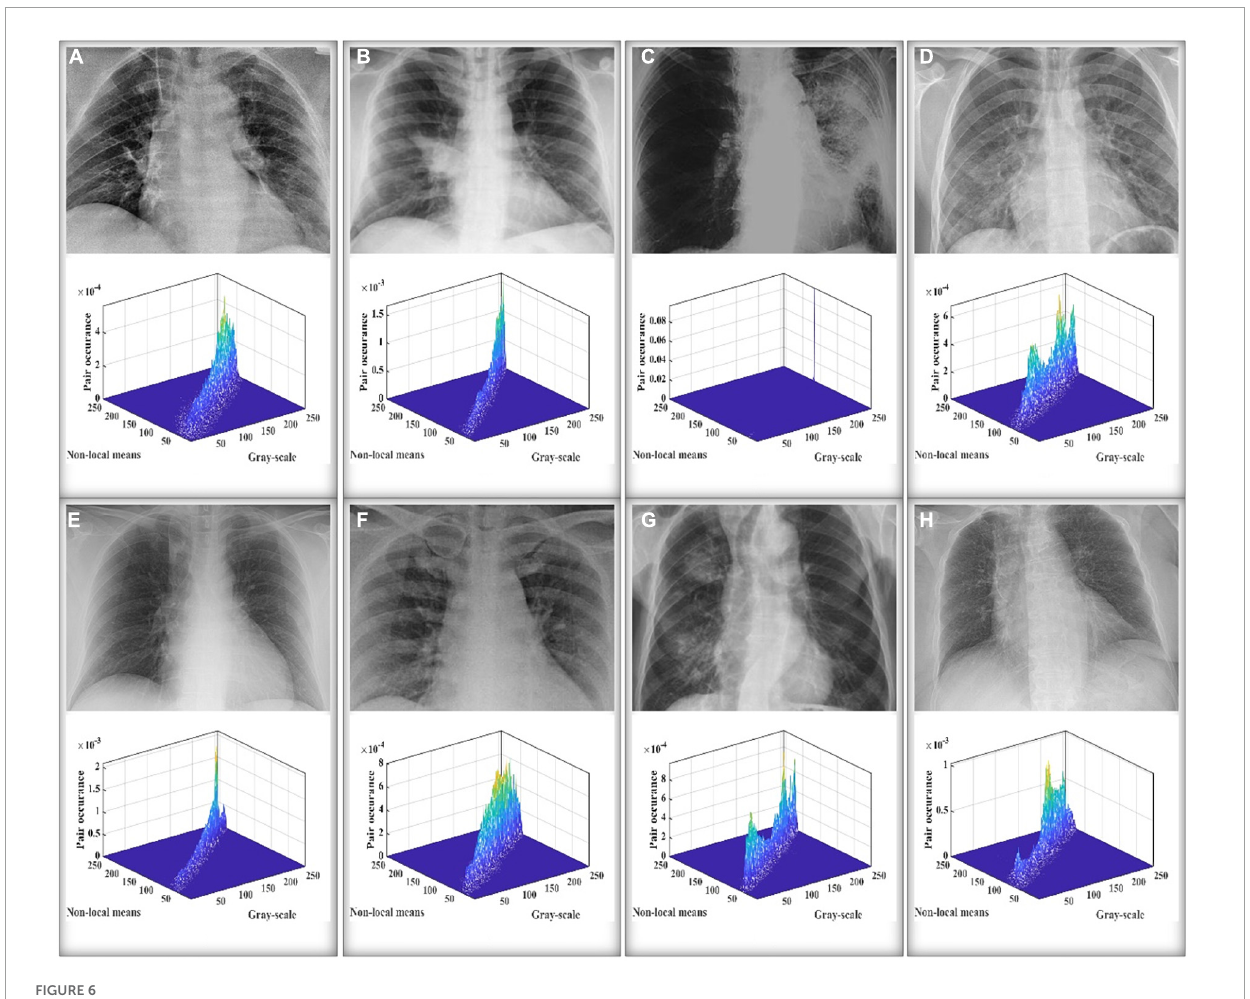
FIGURE6 The COVID-19 X-ray images used in the segmentation experiment.